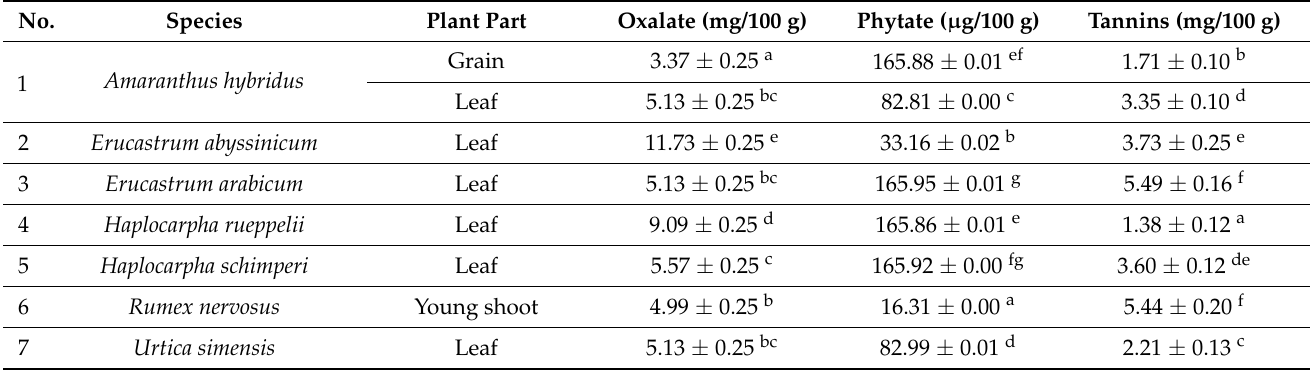
Table 4. Anti-nutritional factors in selected